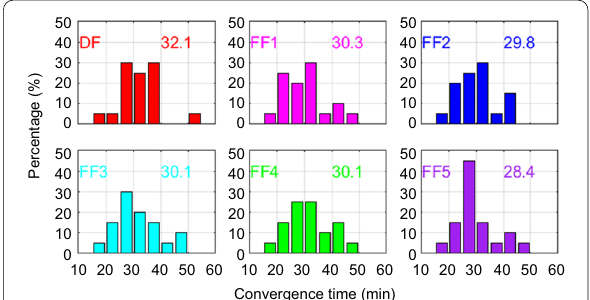
Fig. 7 Distribution of the convergence time with different models for the selected 20 stations